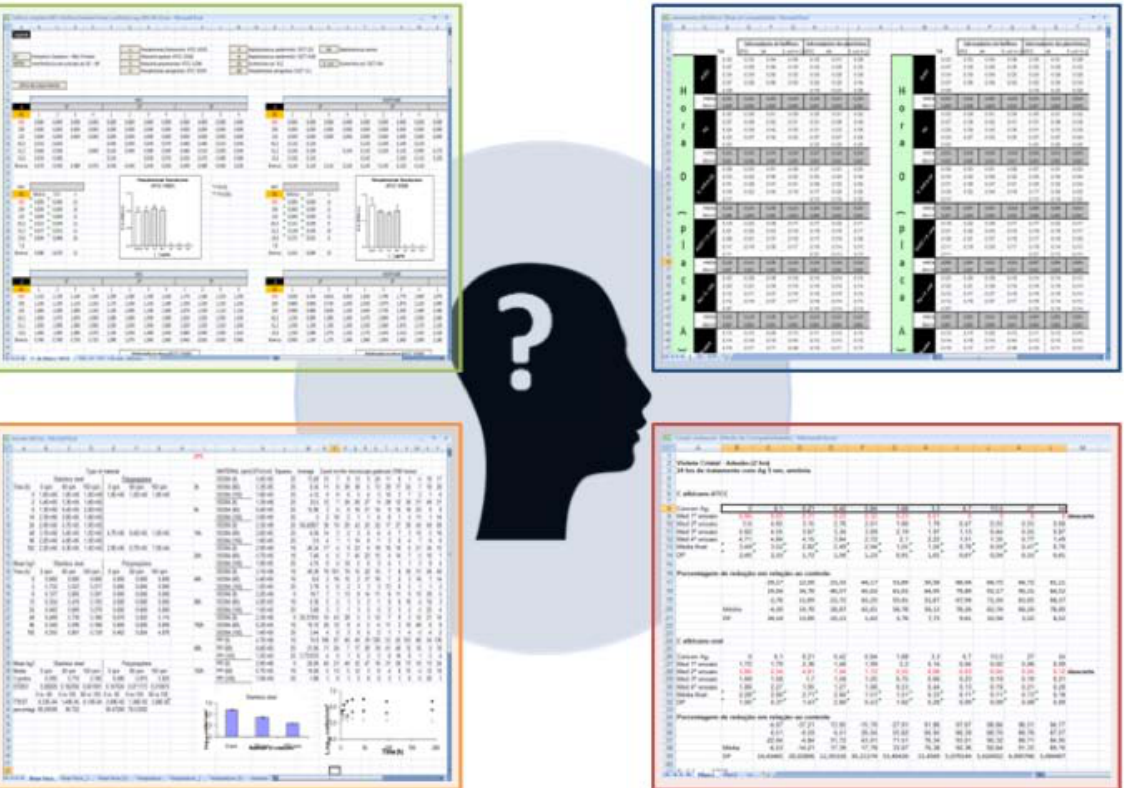
Fig. 1: Examples of original data files from already published